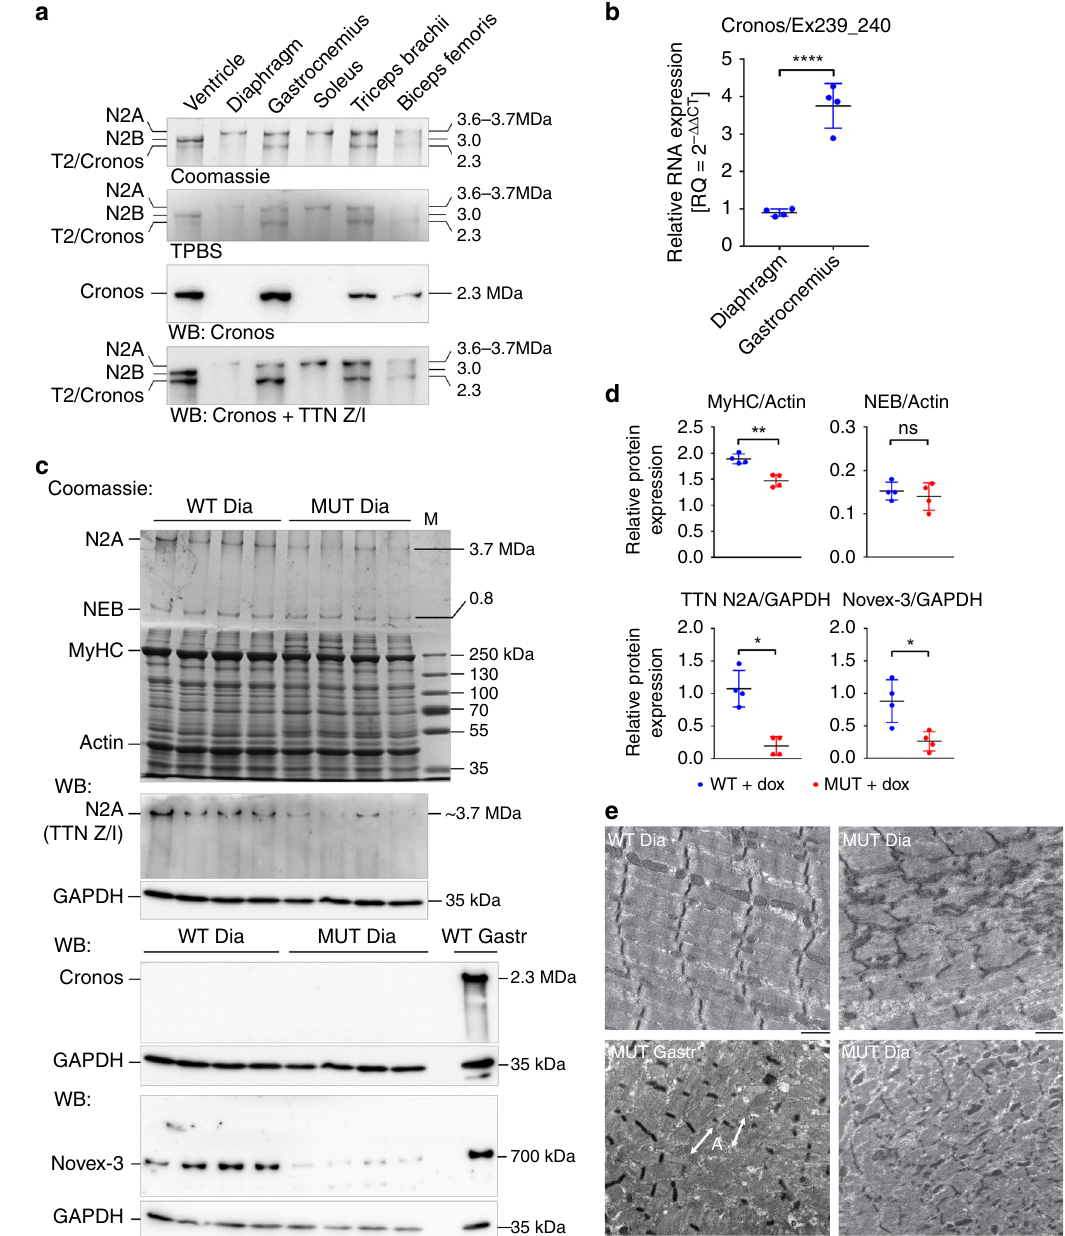
Fig. 6 Differences in Cronos expression and A-band stability between muscle types. a Expression of full-length TTN and Cronos in different muscle types of wild-type mice. Top panel, Coomassie-stained, 2% SDS-polyacrylamide gel; lower two panels, western blots (WB) using antibodies to Cronos or both Cronos and full-length TTN (antibody 2080 against TTN Z/I). TPBS, total protein stain of blotted TTN proteins. Gels and blots shown are representative of 2 – 3 gels/WBs performed per condition. b Relative Cronos mRNA expression in wild-type mouse muscles measured by qPCR; n = 4 mice/group. **** p < 0.0001, by two-tailed unpaired Student ’ s t -test. c Coomassie-stained titin gel (2.5% polyacrylamide) stacked onto a 10% running gel and loaded with protein lysates from WT ( n = 4) and MUT ( n = 4) Ttn tm1c ;ACTA1-rtTA;tetO-cre diaphragm muscle after dox-treatment (top panel). M, marker. Lower panels show representative western blots detecting expression of TTN isoforms in dox-treated WT and MUT diaphragm muscles. Full-length titin (N2A) was probed by antibodies to TTN Z/I (2080). GAPDH served as loading control. d Results of densitometric quanti fi cation ( n = 4 mice/group); MyHC/ Actin and NEB/Actin ratios were measured on Coomassie-stained titin gel, N2A, and Novex-3 expression on western blots, relative to GAPDH. Data are mean ± SD; ** p = 0.0016, * p N2A = 0.0286, * p Novex3 = 0.014, ns, non-signi fi cant; calculated using a two-tailed unpaired Student ’ s t -test. e Representative electron micrographs (out of >20 images recorded per condition) of WT (upper left panel) and MUT (right panels) mouse diaphragm muscles after dox- treatment. For comparison, the lower left panel shows a dox-treated MUT gastrocnemius myocyte. Arrows labeled A point to remnant, isolated A-bands. Bars, 1 µ m. All data were obtained after ~30 days of dox-treatment. Source data are provided as a Source Data fi